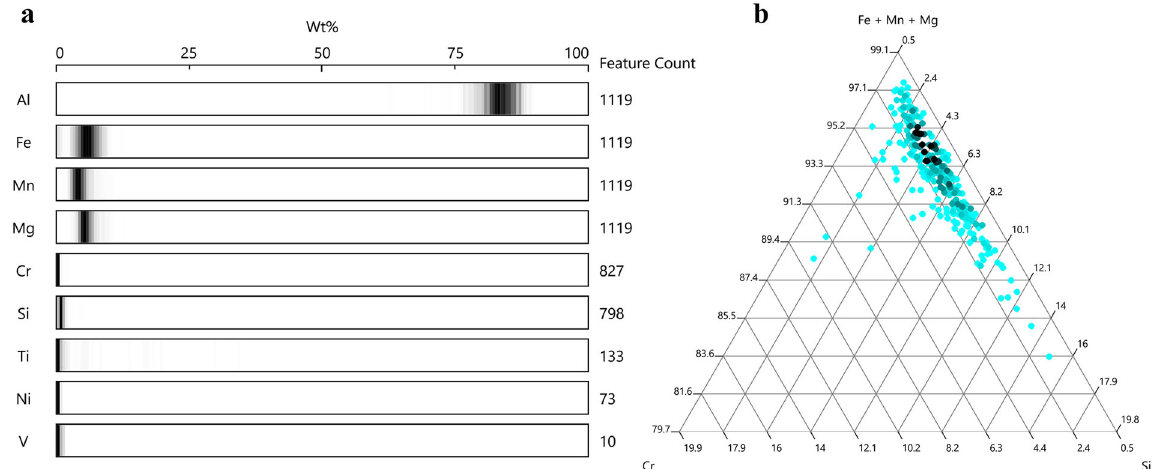
Fig. 3 Abundance and distribution of elements in the analyzed particles. a Weight normalized genome graph; b Ternary phase diagram showing the content of Cr and Si elements as second and third most abundant elements in the particles of this alloy. Further exploration of the microstructure shows the presence of particles in the inspected area was 1119 counts. Figure 3 depicts needle shape precipitates, mostly in the interlayer regions (fusion the results of particle chemistry analysis. The Genome graph in Fig. 3a shows that all of the 1119 analyzed particles were found rich in lines). In this study, a length of 6.5 mm that crosses over three Fe, Mn, and Mg, while 74%, 71%, 12%, 6.5%, and 0.9% of the particles contained Cr, Si, Ti, Ni and V, respectively. Figure 3b deposition layers was investigated. The number of analyzed npj Materials Degradation (2021) 26 Published in partnership with CSCP and